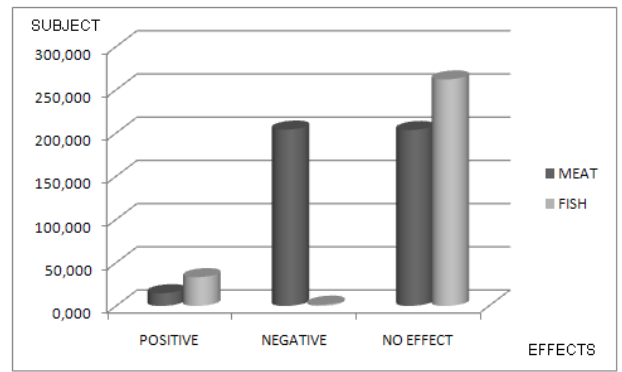
Figure 2. Association between meat and fish dietary patterns and effects on bone mineral density (BMD) or risk of fractures (in % of total study population).